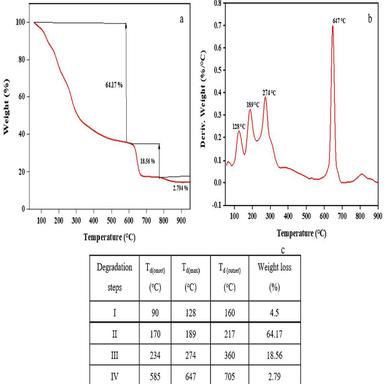
Thermogravimetric analysis of HPMC /copper nanobiocomposites.